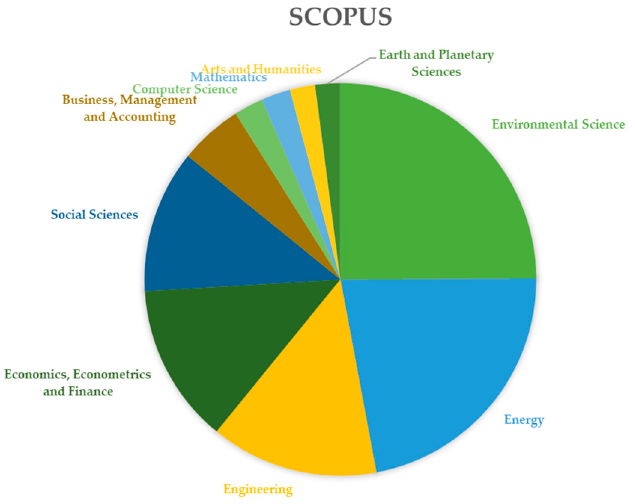
Figure 10. Top 10 subject areas in Scopus based on articles published annually using second query. Source: Own elaboration.